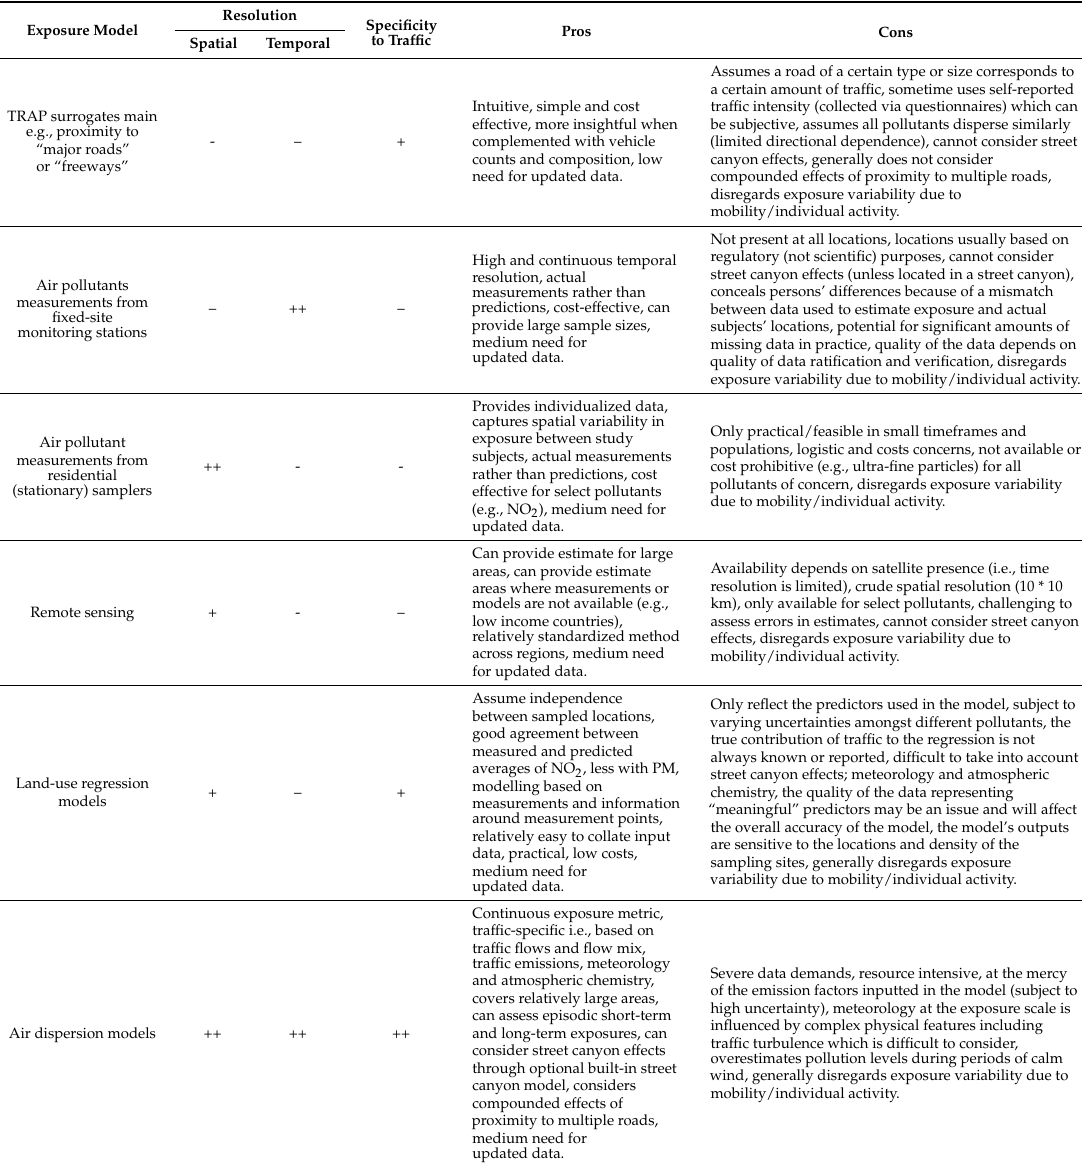
Table 2. Pros and cons of exposure assessment methods used in the systematic review literature. TRAP: traffic-related air